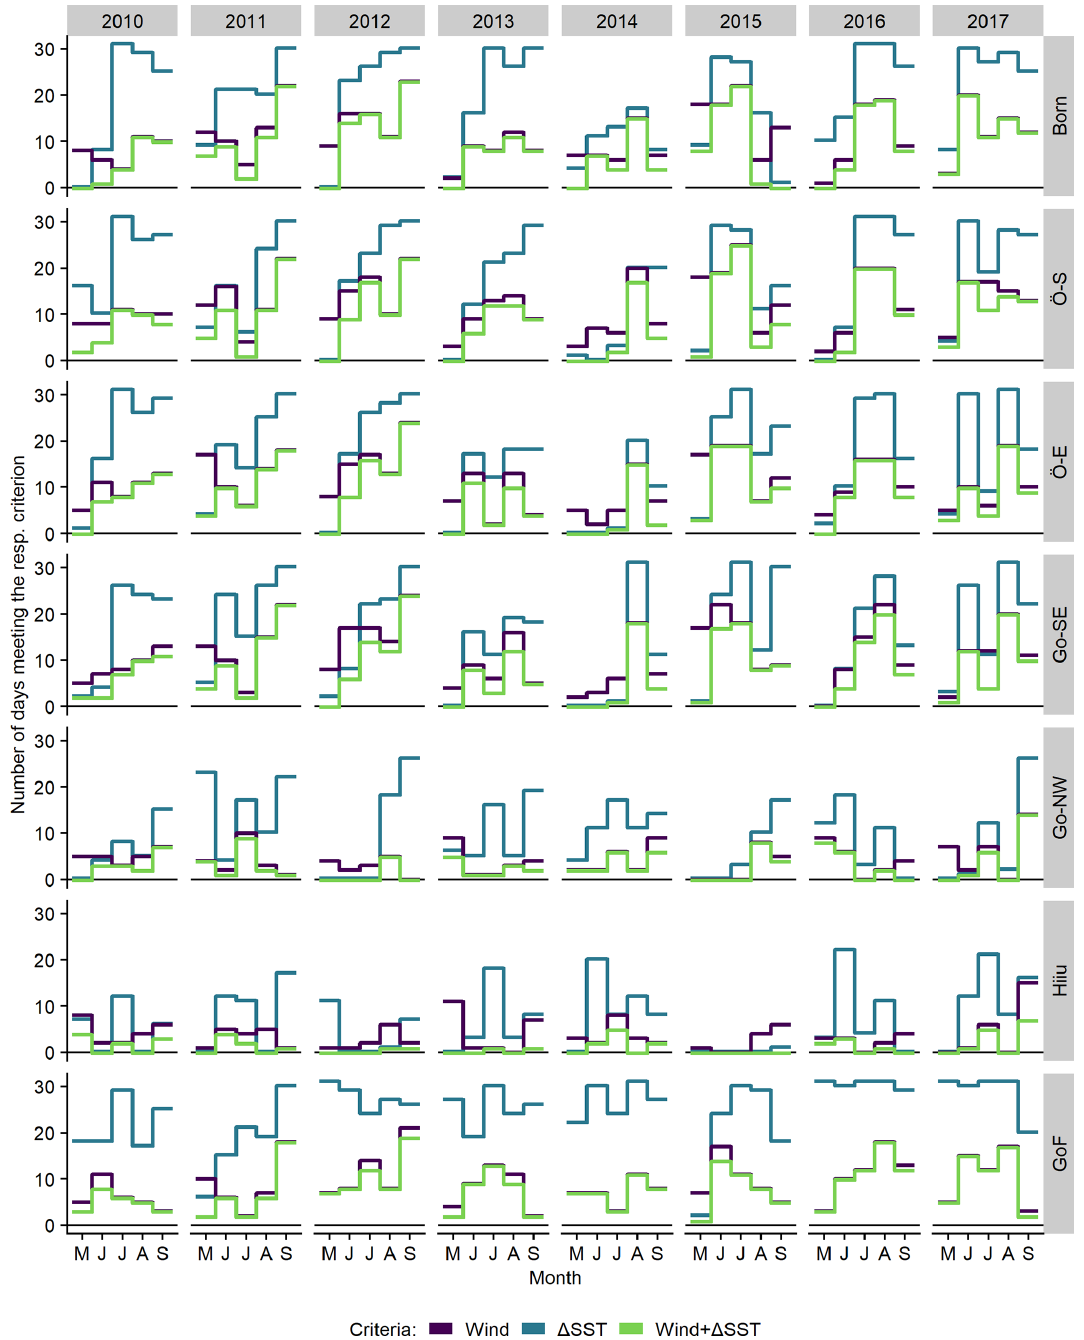
Figure B2. As Fig. 5, but further distinguished by year and using a different (cid:49) SST criterion, which was calculated based on the entire area of the boxes (Sect. 2.3; first approach). Month abbreviations denote the period May–September.